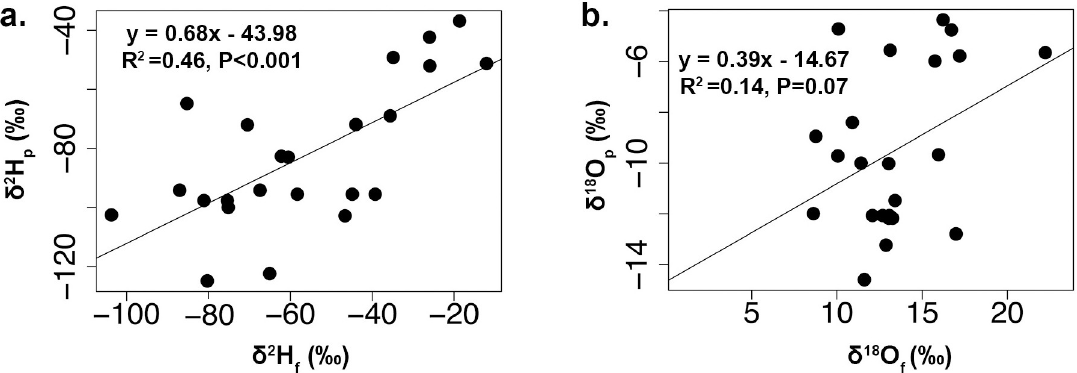
Fig 3. Relationship between the stable isotopic compositions of museum feathers and the isoscape model of precipitation. Stable hydrogen ( δ 2 H F ‰) and oxygen ( δ 18 O F ‰) isotopic composition of feathers for museum Sharp-shinned Hawk ( Accipiter striatus ) specimens of known natal origin and the isoscape modeled isotopic compositions of precipitation ( δ 2 H P and δ 18 O P ‰) at the collection locations: (a) δ 2 H F values of birds ( n = 23) versus δ 2 H P values, (b) δ 18 O F values of birds ( n = 23) versus δ 18 O P